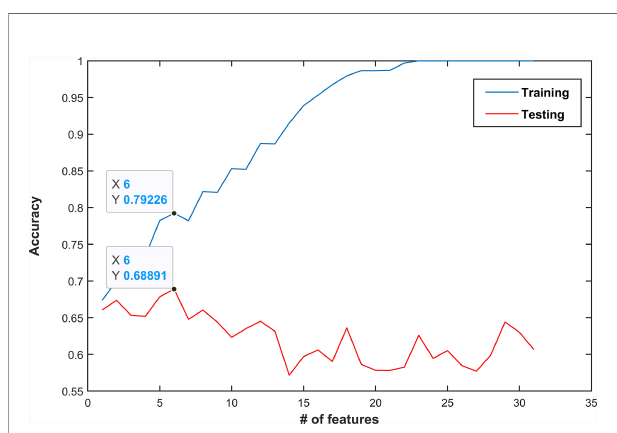
FIGURE 4 | Classi fi cation performance (mean accuracy of a k-fold validation) as a function of the number of features used. Features are ordered by decreasing area under the receiver operating characteristic curve (AUC) values. In this example, the best performance was obtained when the fi rst six features were used (mean accuracy of 0.79 and 0.69 in the training and test set, respectively). Choosing more features would lead to over fi tting and thus decrease performance.